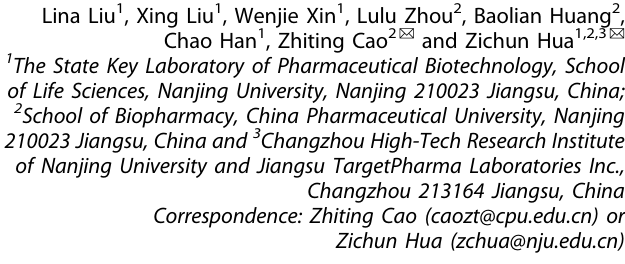
Fig. 1 a The TNF- α nb expression inside bacteria or secreted into LB was detected by western blot ( n = 3). b Expression of TNF- α nb-mCherry under normoxic and hypoxic (1% O 2 ) conditions ( n = 3). c Ratio of splenic DCs after incubated with different groups for 2 h or 6 h ( n = 3). d Proportion of granzyme B + CD8 + T cells after incubated with different groups for 2 h or 6 h ( n = 3). e Counted CD8 + T cell ratio in splenic lymphocytes after RAW264.7 cells incubation ( n = 3). f The organ burden of tumor-bearing mice 5 days after injection ( n = 3). g MFI analysis of representative fl uorescent image of colonized VNP α TNF- α /mCherry (Red; 1 × 10 8 CFU/mouse) and TNF- α nb-mCherry (Red; 150 µg/kg) in tumors ( n = 3). h Tumor growth curves of B16F10 administered with PBS, VNP, or VNP α TNF- α ( n = 6). i The calculated tumor doubling time of different groups ( n = 6). j Overall survival of the tumor-bearing mice ( n = 6). k, l H&E staining of tumors after VNP α TNF- α treatments. Scale bar, 200 µm. N: necrotic region, nN: nonnecrotic region. m The distribution of tumor-in fi ltrating immune cells after VNP α TNF- α administration. 1000 μ m